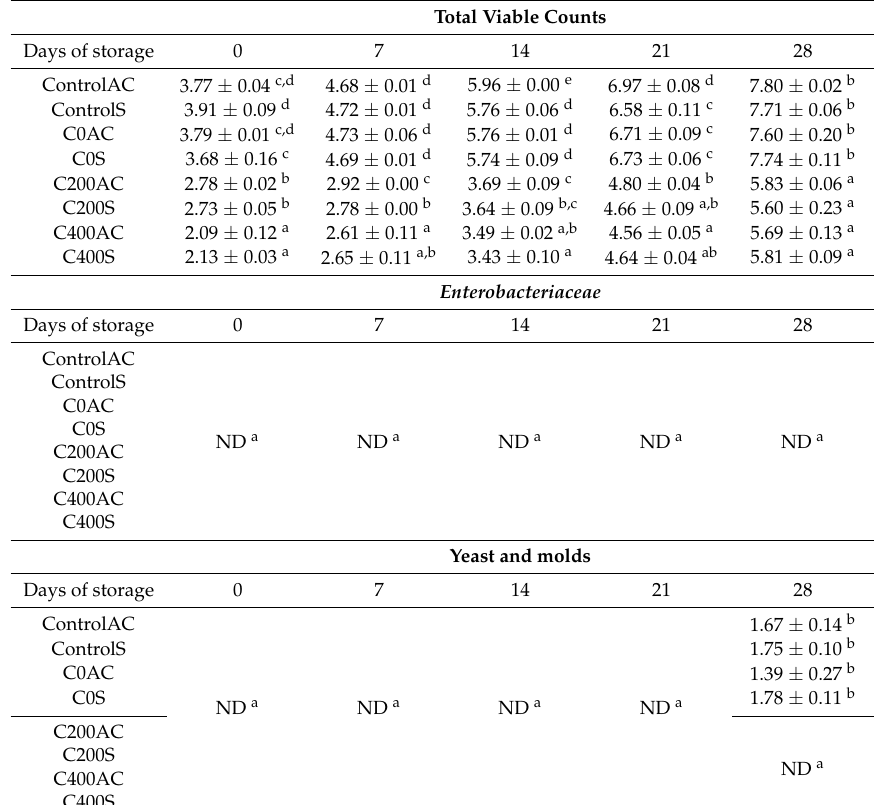
Table 3. Populations of microbial groups during refrigerated storage for 28 days of the sausages covered with the experimental sodium alginate coatings.